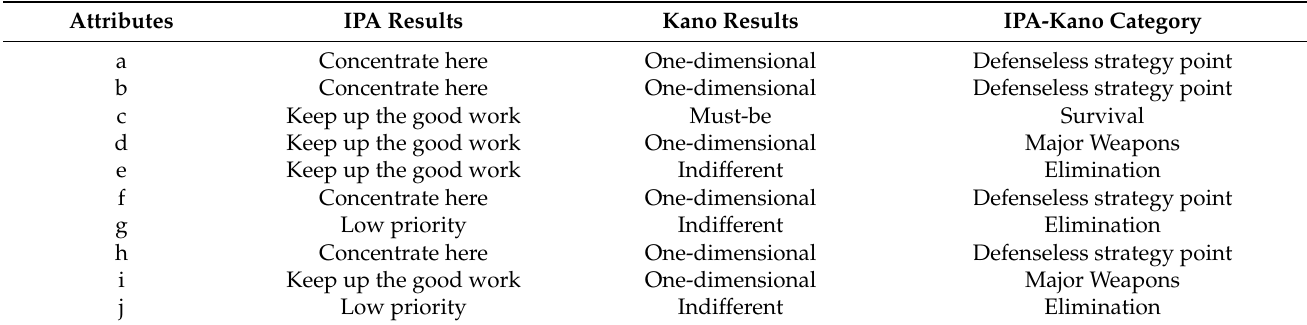
Table 5. Result of Recommendation Category based on IPA-Kano Integration.